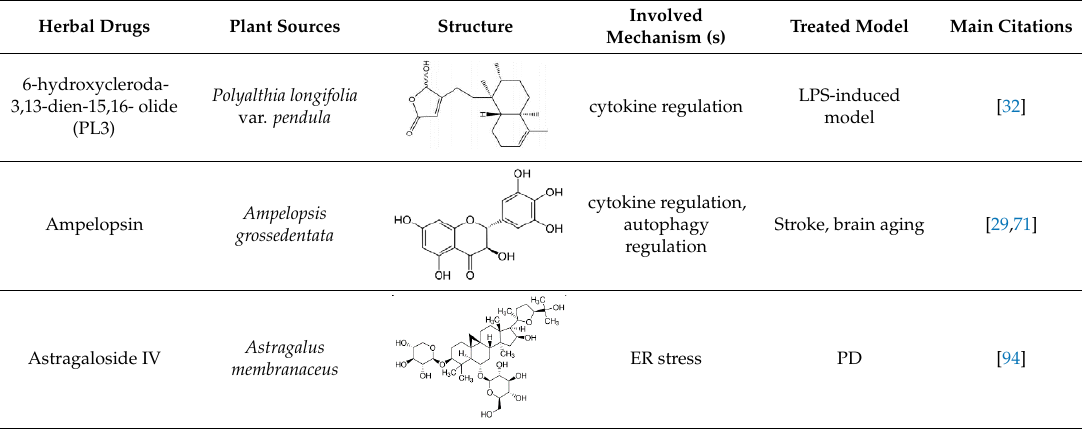
Table 1. Chinese herbal compounds have neuroprotection ability to various neurological disorders through different mechanisms and metabolisms.